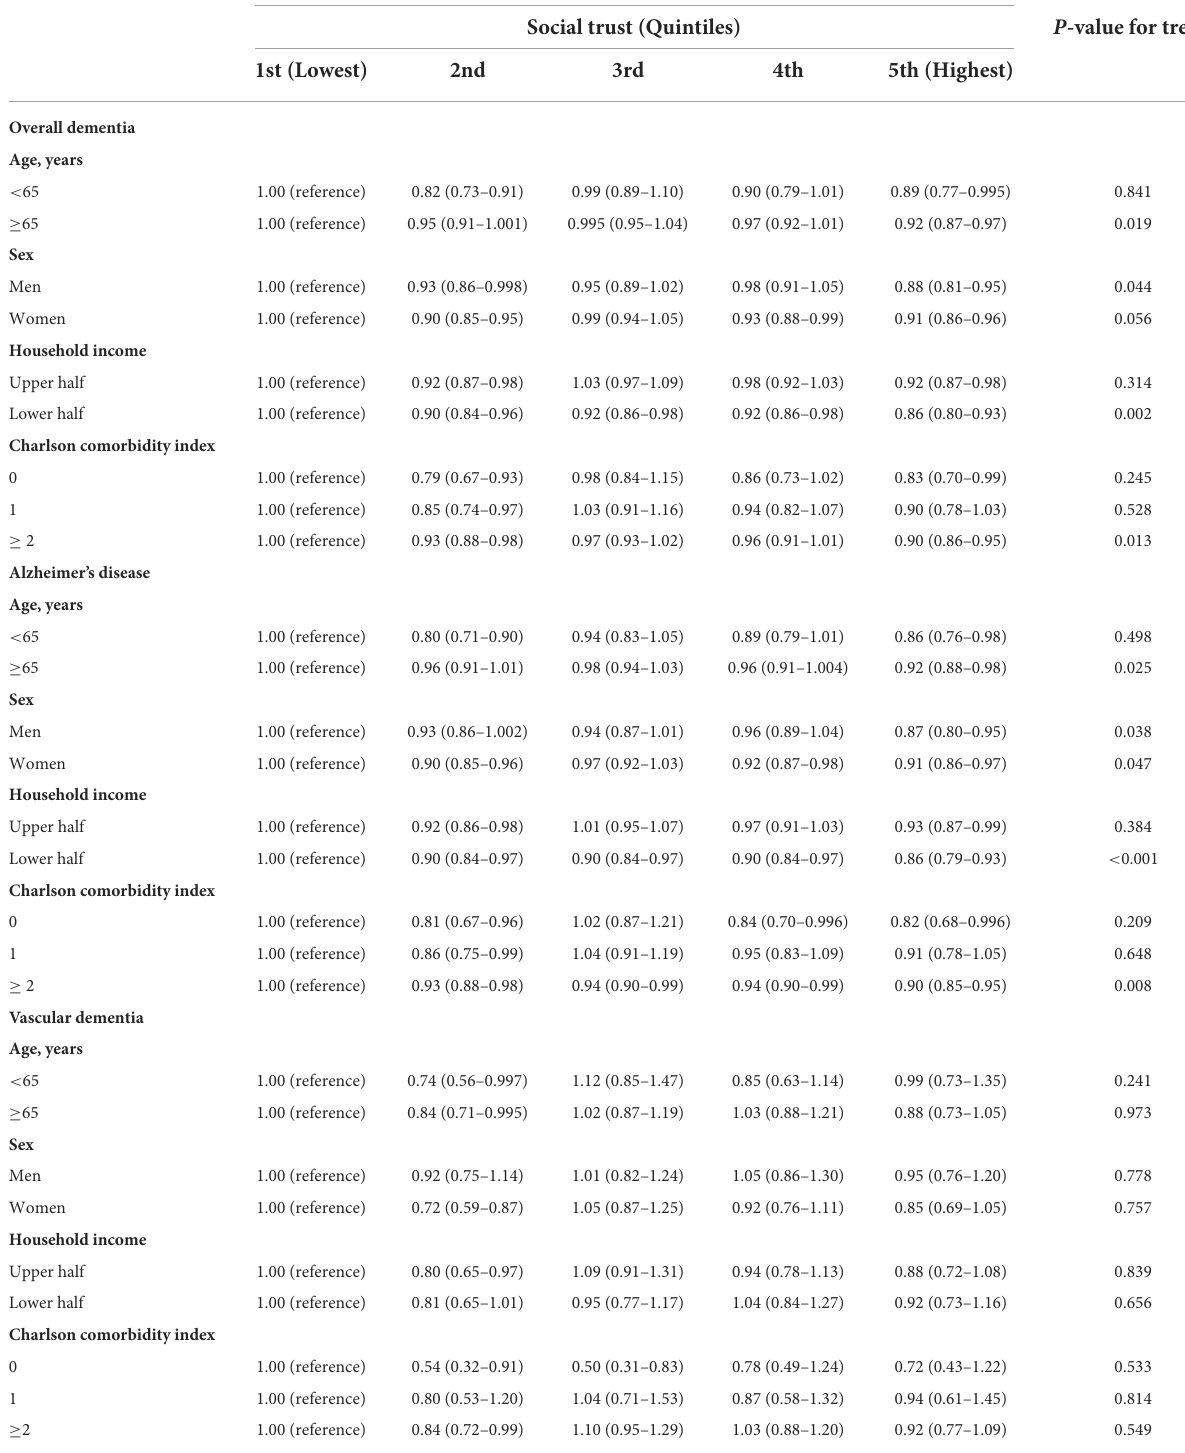
TABLE 3 Stratified analysis on the association of social trust with dementia according to age, sex, household income, and Charlson comorbidity